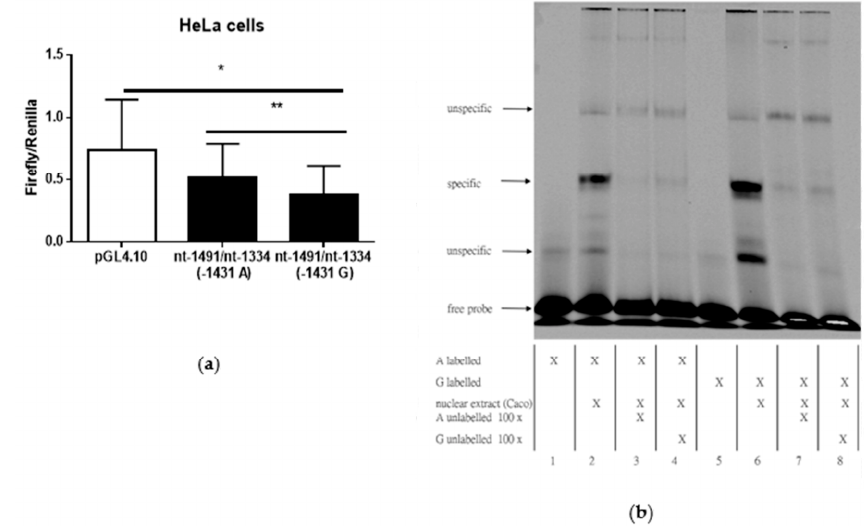
Figure 1. Aquaporin 3 (AQP3) promoter analysis in the promoter region of nt-1334 / nt-1491 ( a ) Luciferase assay showing AQP3 promoter activity in HeLa cells (mean ± SD). In the promoter construct from nt-1334 / nt-1491 activity of A-allele was compared to G-allele ( n = 5). ( b ) Electrophoretic mobility shift assay with oligonucleotides representing the promoter region nt-1418 / nt-1446 and containing the A-allele (lanes 1 to 4) and G-allele (lanes 5 to 8) of the A( − 1431)G polymorphism. Representative blot of three independent experiments. The addition of nuclear extracts to labelled oligonucleotides resulted in the formation of specific bands (lanes 2 and 6). Excess of non-labelled oligonucleotide outcompeted the formation of specific bands (lanes 3, 4 and lanes 7, 8). * p ≤ 0.05; ** p ≤ 0.01.